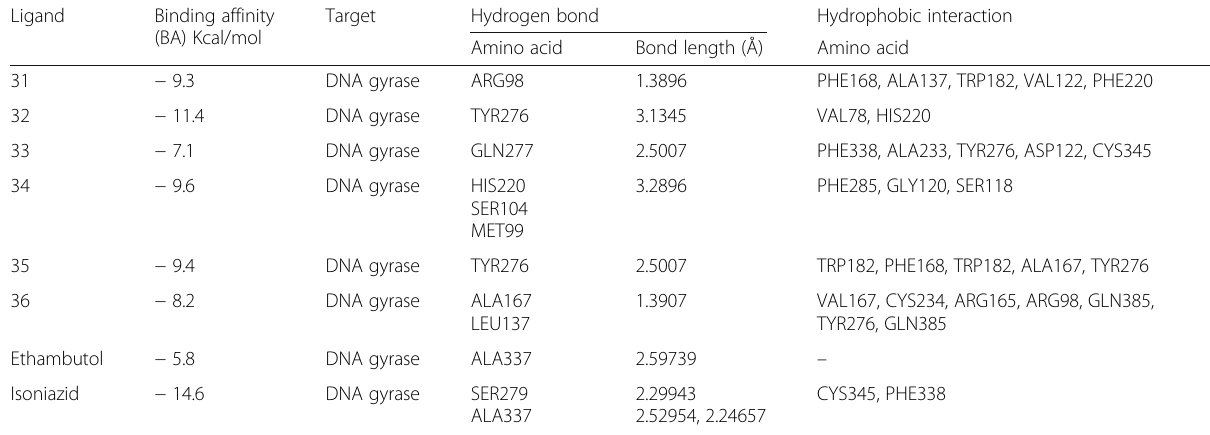
Table 6 Binding affinity, hydrogen bond, and hydrophobic interaction of the ligands (2,4-disubstituted quinolone derivatives) with M. tuberculosis target (DNA gyrase) (Continued)